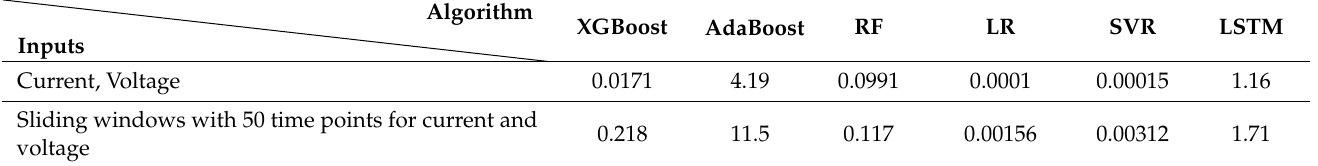
Table 6. The time consumption comparison of each machine learning algorithm for different inputs